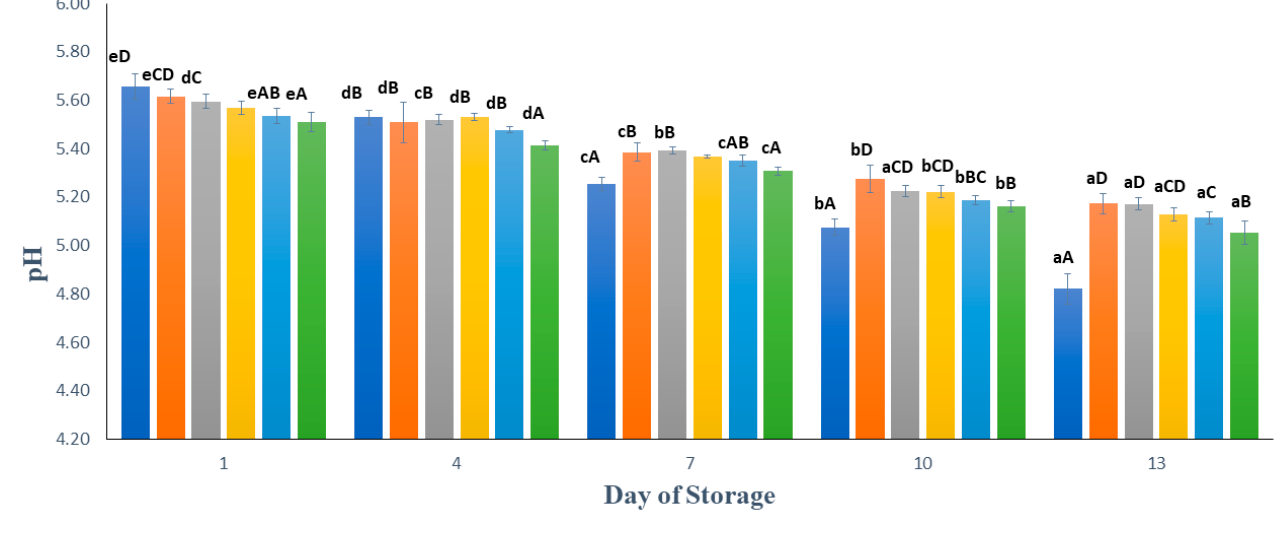
Figure 7. The effect of edible coating from gelatin composite enriched with black tea extract on the pH of watermelon was minimally processed during the storage period. The value shown is the average of the three experimental replications. A–D Values followed by the same capital letters showed no significant difference ( p > 0.05) between treatments on the same day. a–e Values followed by the same non-capital letters showed no significant difference ( p > 0.05) between storage times in the same